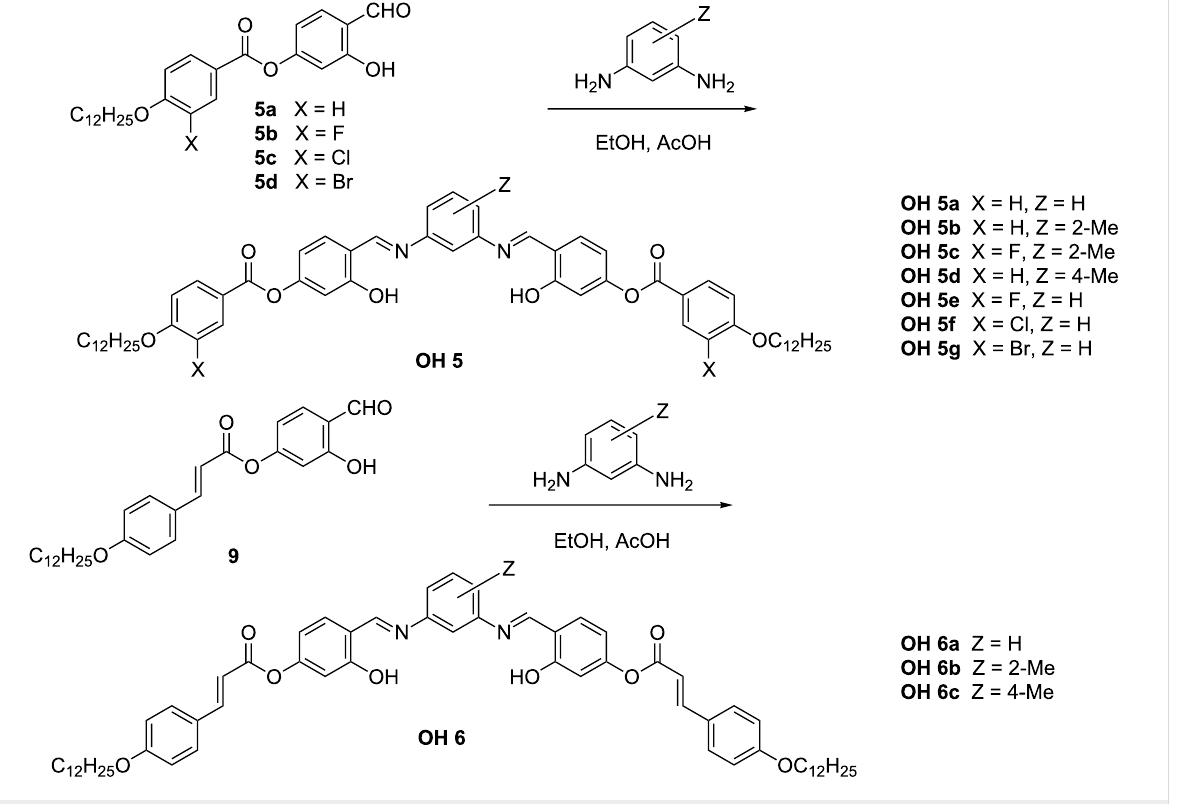
Scheme 5: Reaction steps employed for the preparation of the compounds OH 5 and OH 6 .